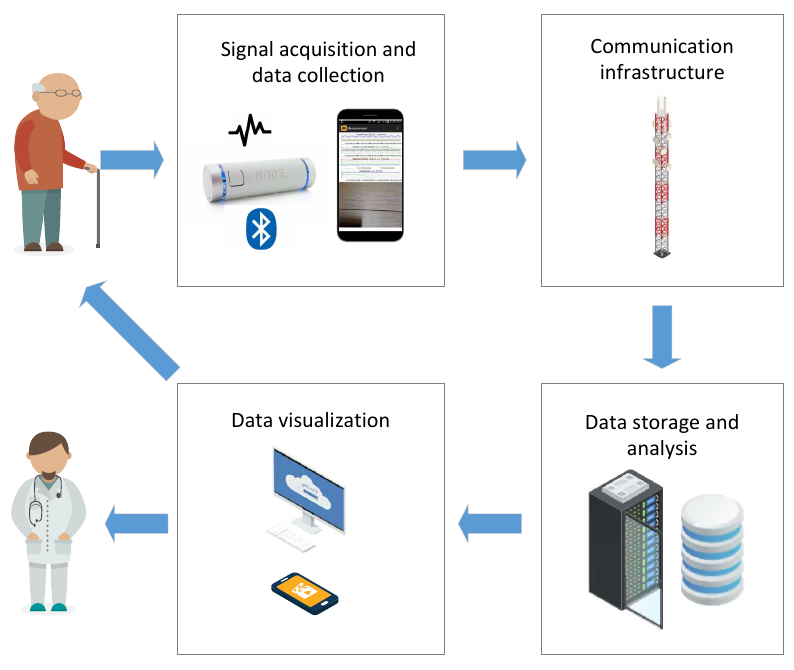
Figure 2. Architecture of IoT healthcare